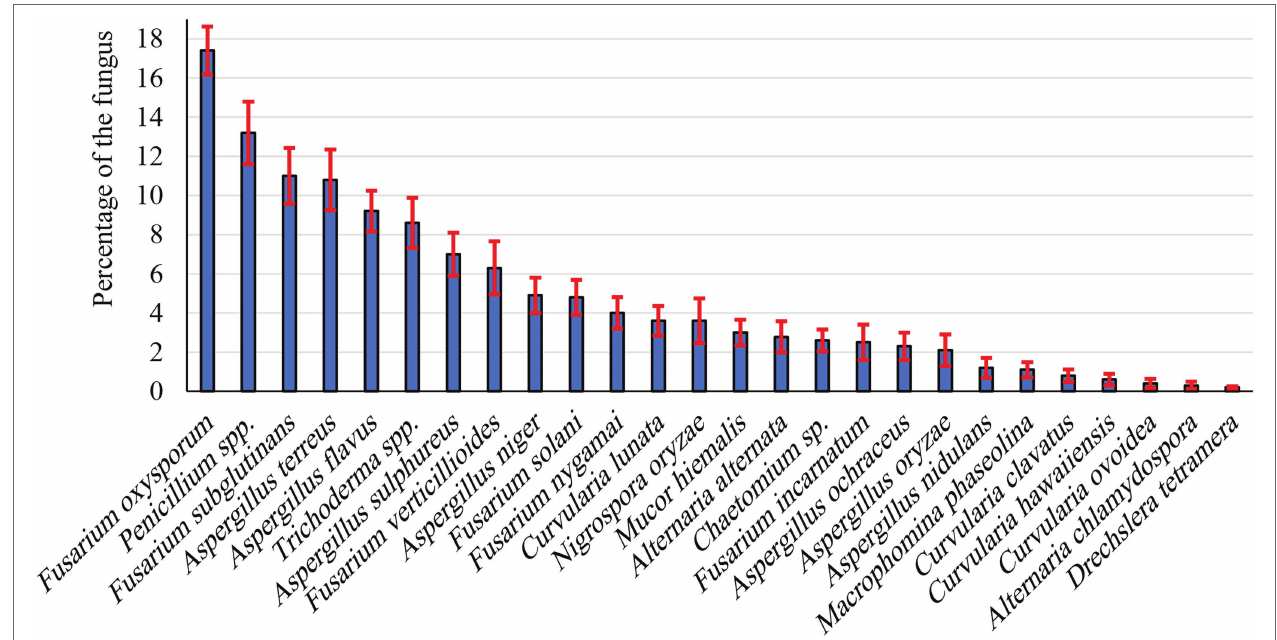
FIGURE 1 | Prevalence of endophytic fungal species isolated from peanut